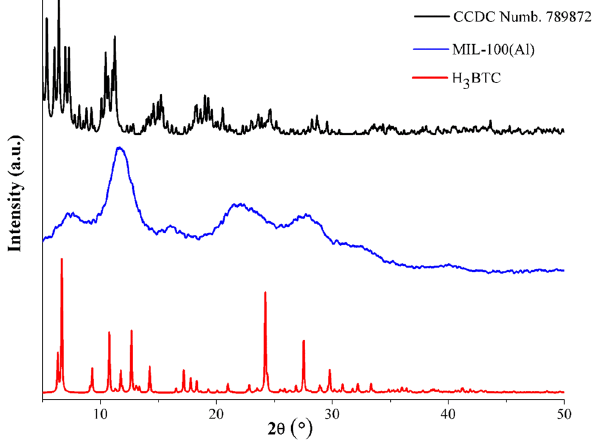
Figure 2: Di ff ractogram of synthesized MIL - 100 ( Al ) as compared with the standard patterns of CCDC No. 789872 and the H 3 BTC ligand ( ICSD No. 30245 ) .